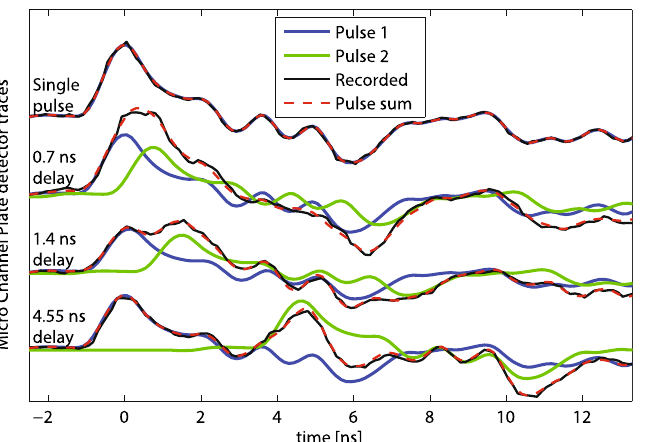
Figure 5. Micro-Channel Plate traces for different two-bucket delay configurations in the short delay regime. The recorded signal (black) is decomposed in the sum (dashed red) of two contributions, the leading pulse (blue) and the trailing pulse (green). The recorded signal has been filtered in the frequency domain removing components corresponding to 1, 2 and 3 samples separation.